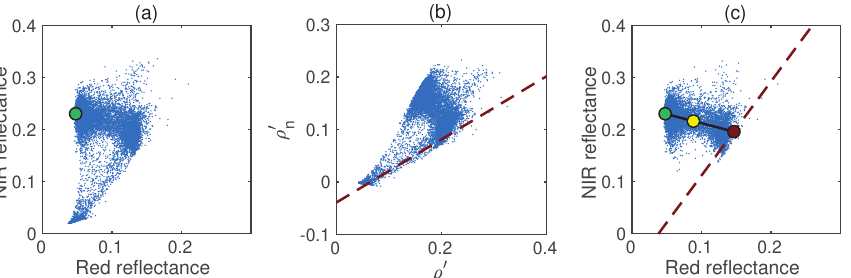
Figure 3. Schematic diagram illustrating the pseudo-endmember computation. Blue dots indicate the MODIS reflectance spectra over the Tokai region for 14 March 2018. ( a ) Computation of the pseudo-vegetation endmember spectrum (green circle). ( b ) Estimation of the soil line-like equation using quantile regression over the rotated reflectance space (dashed line). ( c ) Computation of the pseudo-non-vegetation endmember spectrum (brown circle) using the vegetation endmember spectrum (green circle) and the spectrum consisting of the mean values (yellow circle) computed using the target spectra without water bodies.